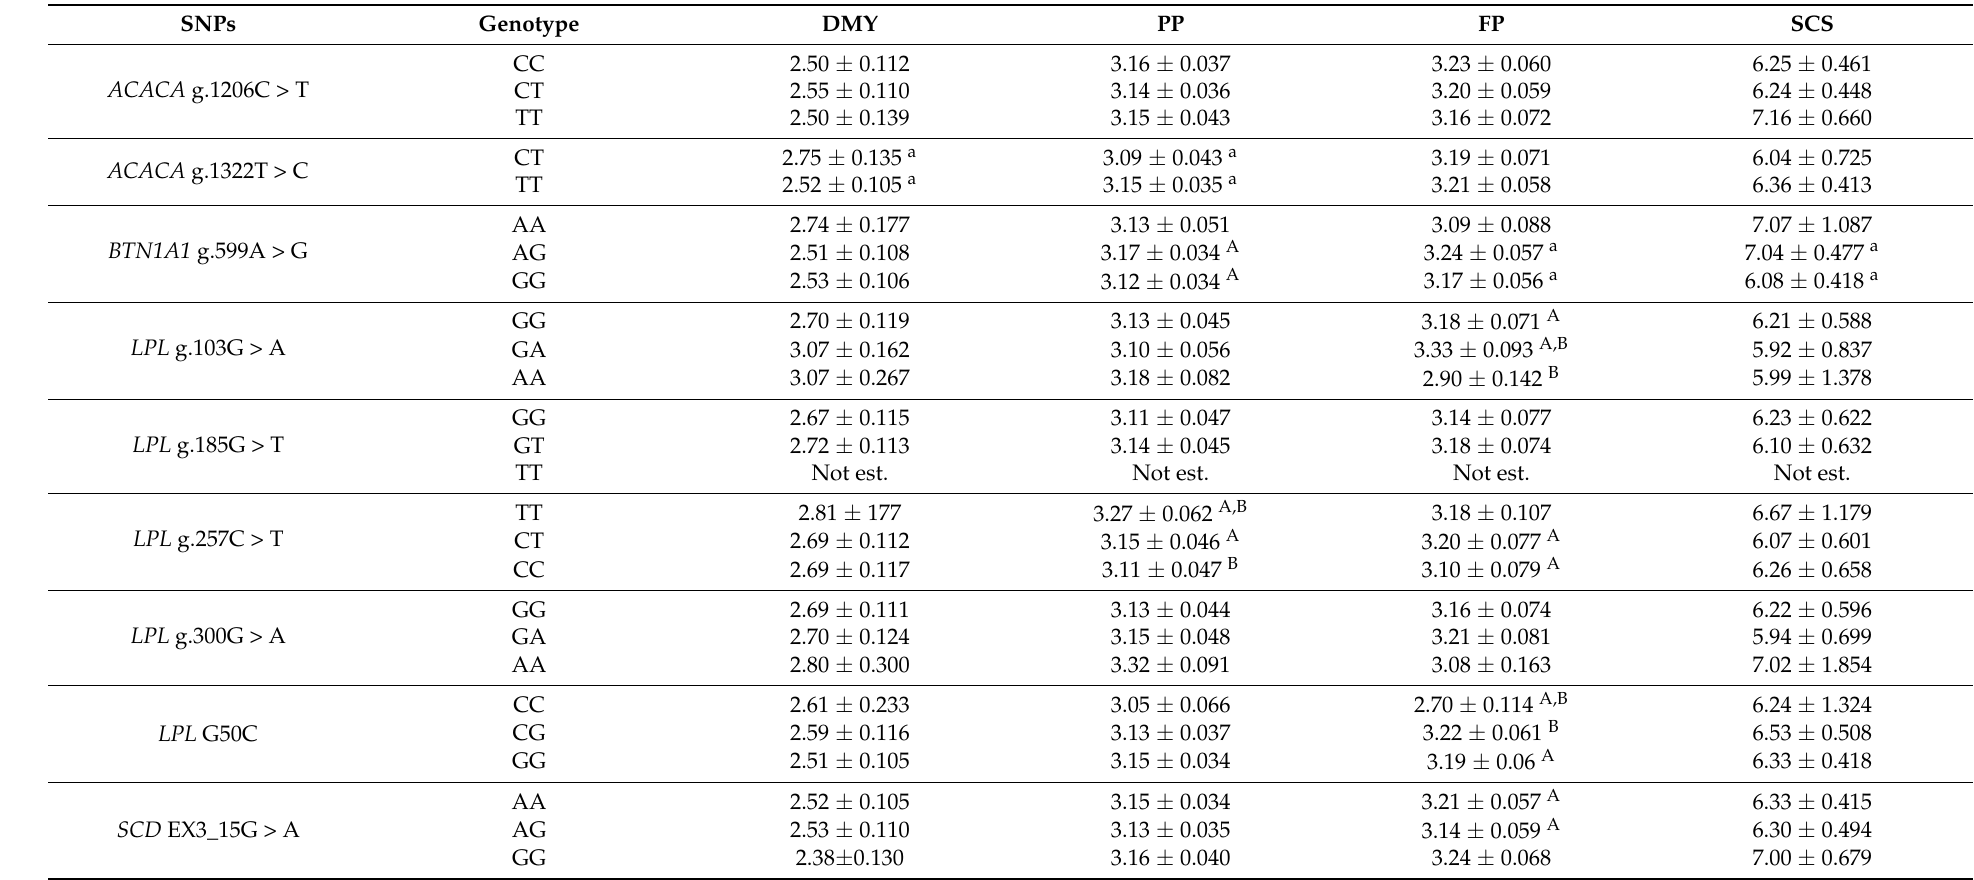
Table 6. Daily milk yield, protein, and fat percentage, and somatic cell score (LSM ± SE) and differences among